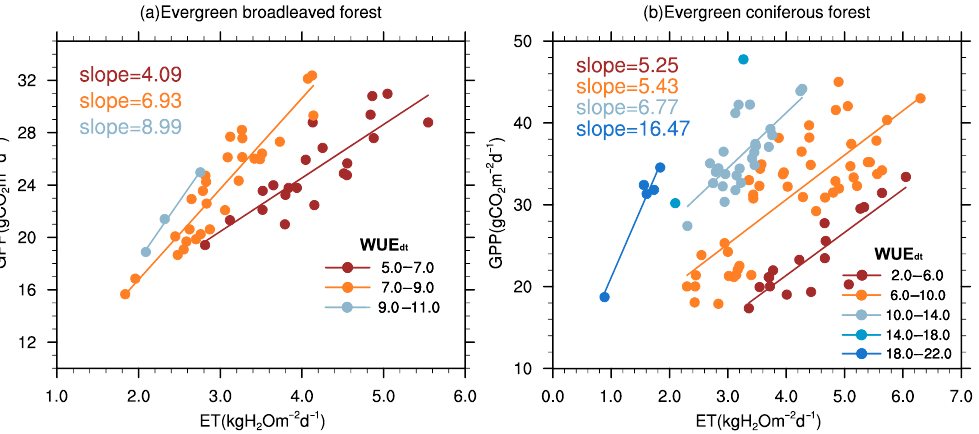
Figure 9. The daily GPP and ET relationship in the broadleaved forest at Dinghushan ( a ) and in the coniferous forest at Qianyanzhou ( b ) with different values of WUE dt in colors. The slope of each regression line is listed in different colors. All values are on summer no-rain days over 2003 – 2005.